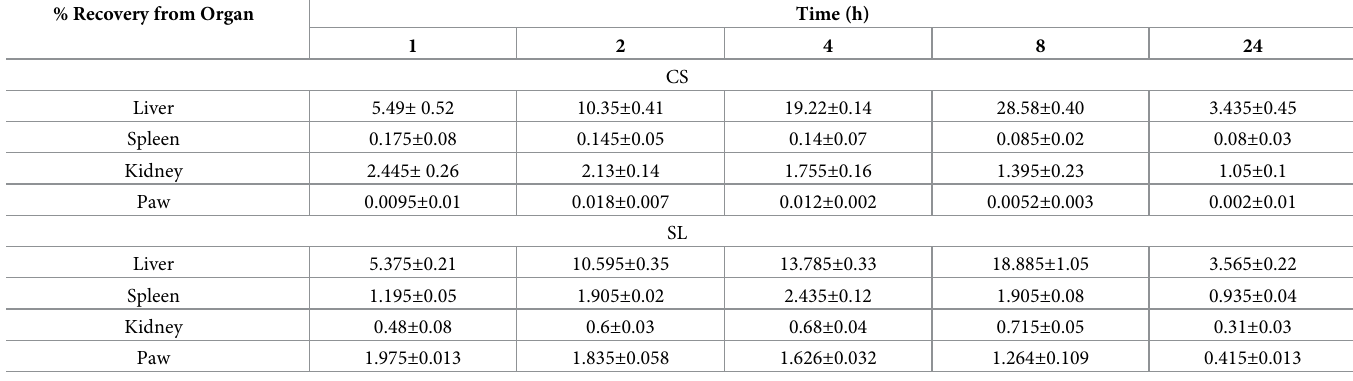
Table 6. Recovery of CLB as % of administered dose in different organs at various time intervals following i.v. injection of free CLB solution (CS) and CLB stealth liposomes (SL) to arthritic rats (dose 1mg/kg). % Recovery from